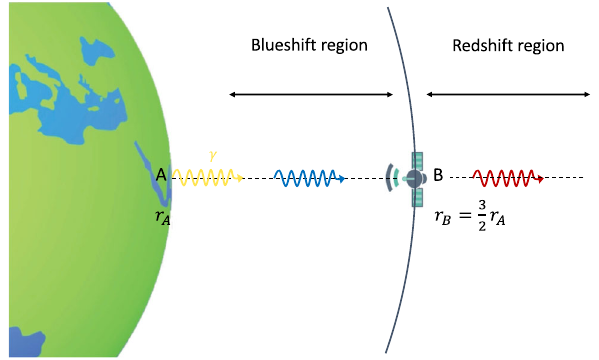
Fig. 1 Wehaveillustratedwhathappenstoaphotonsentbyanobserver A on Earth and received by an observer B on a satellite in circular orbit. The formula for the frequency shift of the photon is given by Eq. (7) and tells us that in GR one has the pure static gravitational contribution, ΔΦ = Φ( r ) − Φ( r ), plus a piece related to the geodesic motion of A B the satellite, r B Φ (cid:4) ( r B )/ 2 (cid:5) Gm /( 2 r B ), which can be interpreted as a r A the photon is seen blue- special relativistic contribution. For r B < 3 2 shifted by the observer B as the contribution due to the satellite motion r A the two is dominant over the gravitational gradient ΔΦ ; for r = 3 2 r A the term ΔΦ dominates effects compensate each other; for r B > 3 2 over the special relativistic one and the photon is seen red-shifted by the observer